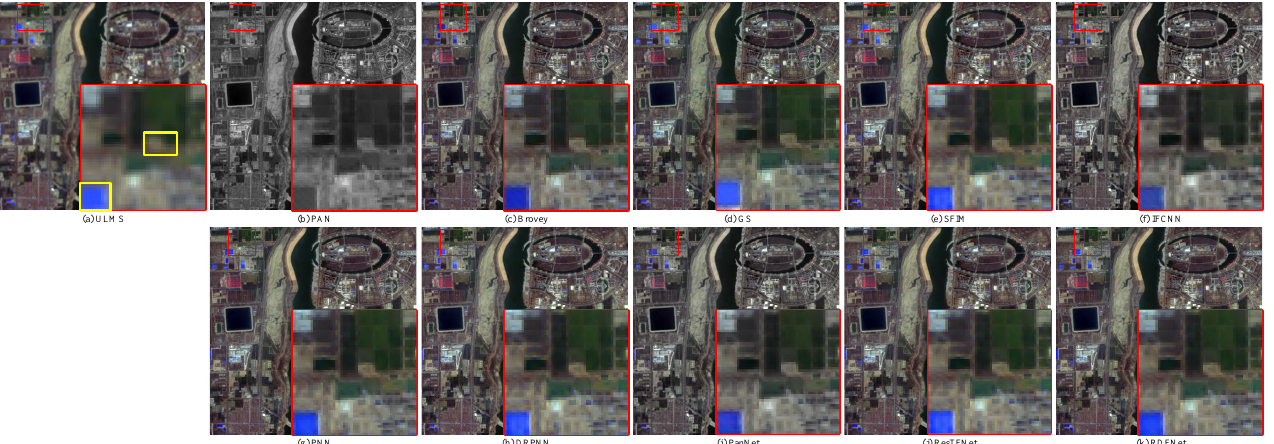
Figure 28. Subjective comparison between RDFNet and the current mainstream fusion methods for fusion results on the Landsat-8 testing dataset with full resolution. ( a ) ULMS; ( b ) PAN; ( c ) Brovey; ( d ) GS; ( e ) SFIM; ( f ) IFCNN; ( g ) PNN; ( h ) DRPNN; ( i ) PanNet; ( j ) ResTFNet; ( k ) RDFNet